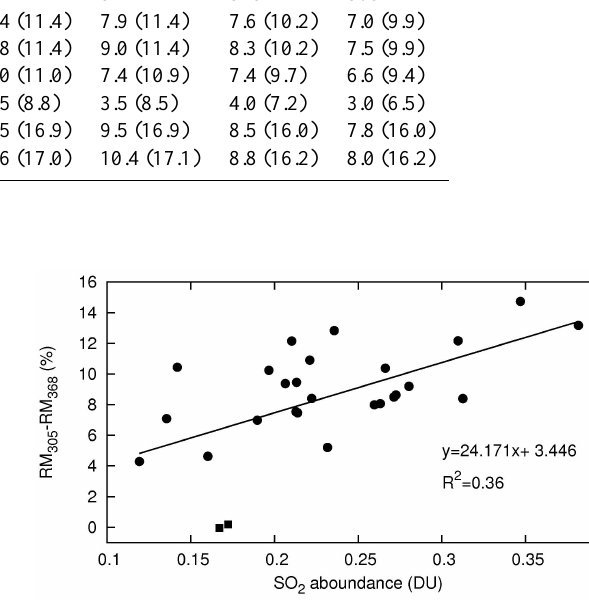
Fig. 3. The scatter diagram of the RM differences (%) between 305 and 368nm versus the climatological mean total tropospheric abundances (DU) of SO 2 ( solid points ) for the 27 UVMRP. Also shown are the respective linear regression function and correlation coefficient, with the fitting line for SO 2 ( solid ). Two high elevation sites (AZ02, CO12) are distinguished by squares because of doubt on SO 2 abundance by data